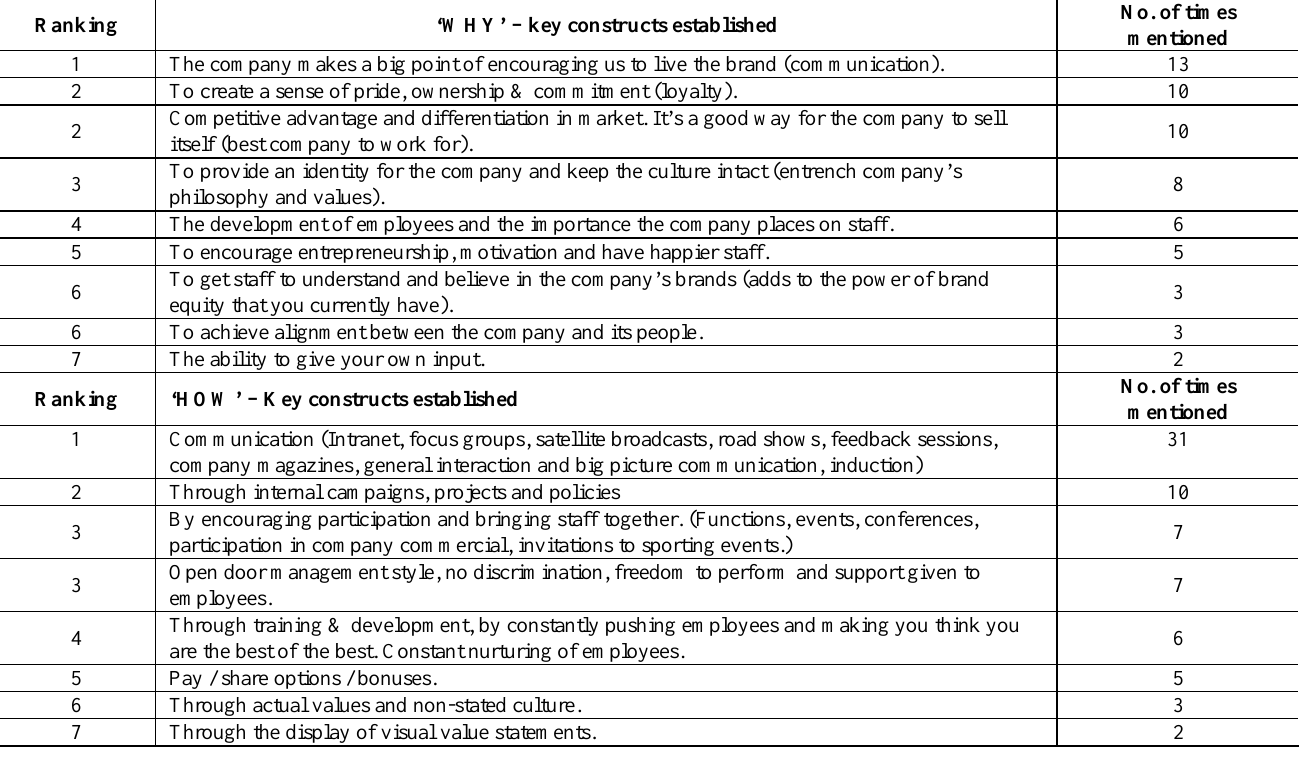
Table 2: Consolidated content analysis Ranking